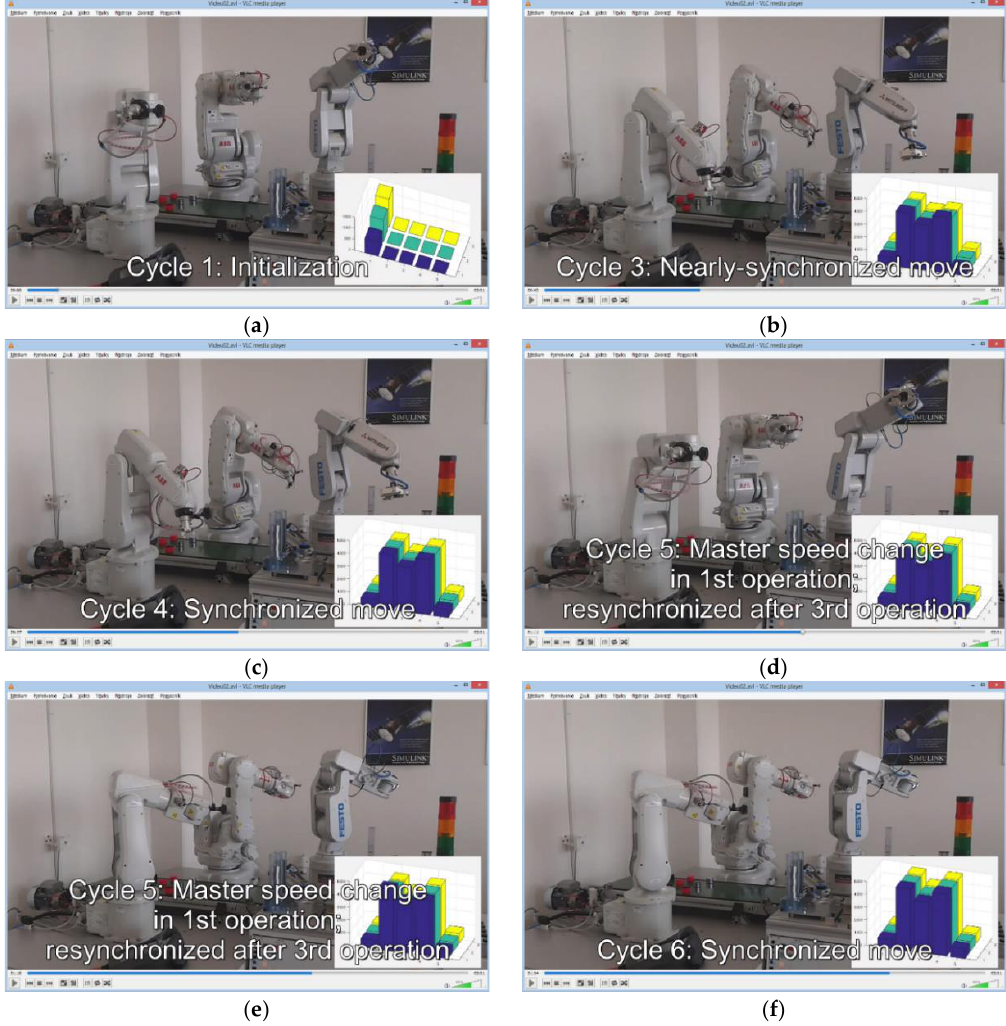
Figure 20. Implementation and visualization – synchronization with feedforward effect. ( a ) Initial cycle; ( b ) Nearly-synchronized state; ( c ) Synchronized state; ( d ) Master speed change cycle; ( e ) Resynchronized state in the same cycle; ( f ) Synchronized state.